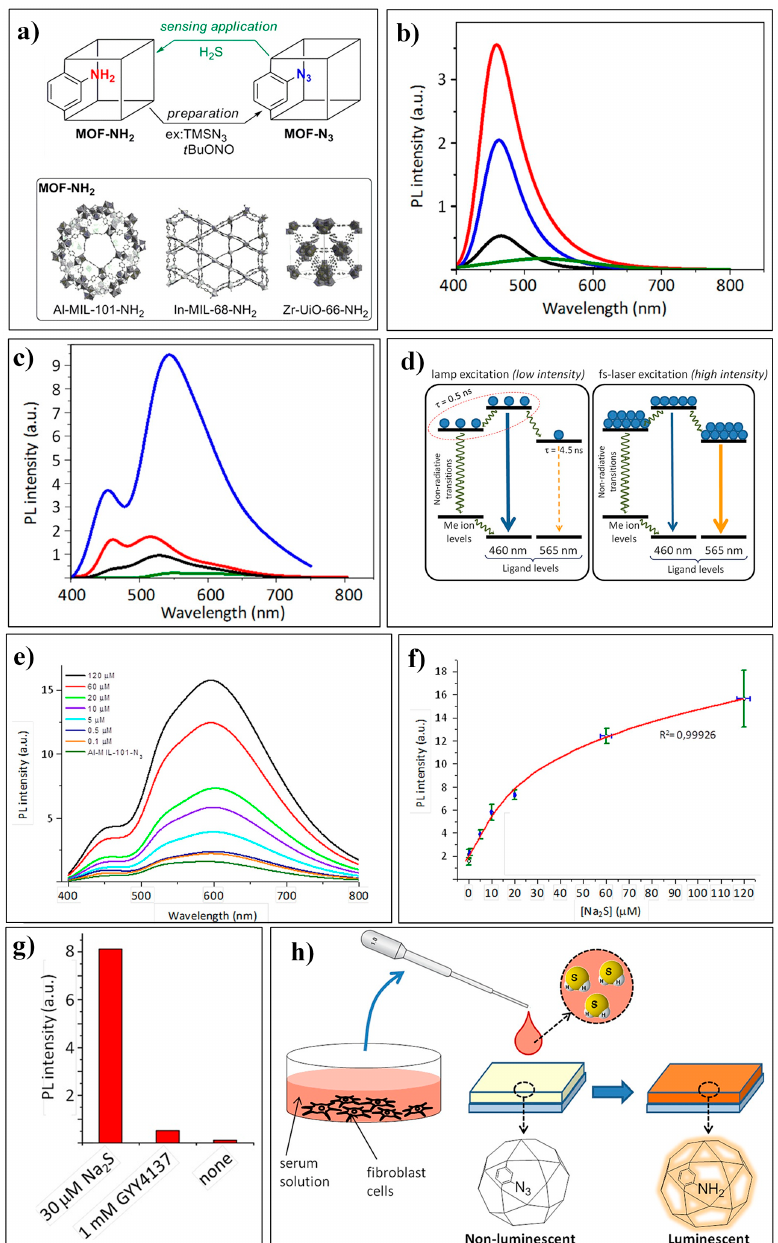
Figure3. ( a ) Azido-MOFsfor H 2 S sensing. ( b , c ) Emissionspectra of dryMOF samples, Al-MIL-101-NH 2 (blue), In-MIL-68-NH 2 (red), Zr-UiO-66-NH 2 (black), Al-MIL-101-N 3 (green) under UV-lamp excitation ( b ) or fs-pulse laser excitation ( c ) at 343 nm. ( d ) Proposed schematic mechanisms of charges recombination underpinning the observed switch in emission channels. ( e ) Emission spectra of Al-MIL-101-N 3 in the presence of di ff erent concentrations of sodium sulfide (excited at 343 nm with a fs-pulse laser). ( f ) Reversed cubic fit of sodium sulfide concentration vs. measured intensity of the 565 nm band in emission spectra. ( g ) Detection of H 2 S released from GYY4137. ( h ) Exposure of Al-MIL-101-N 3 to a sample of culture medium for cells with endogenously produced H 2 S. Reproduced with permission from [79]. Copyright Wiley-VCH,